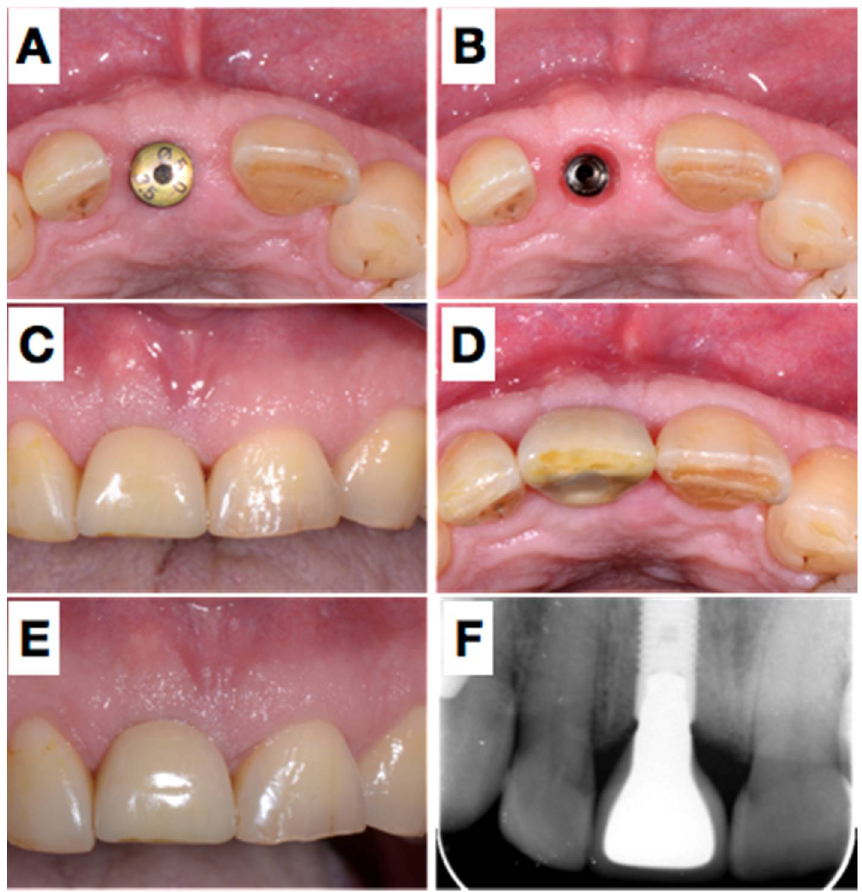
Figure 5. 5 weeks later ( A ), the healing abutment was removed ( B ) and an impression was taken. Panels ( C , D ) show the situation after placement of the definitive crown placement (screw-retained) and the result two years later, clinically and radiographically ( E , F ).